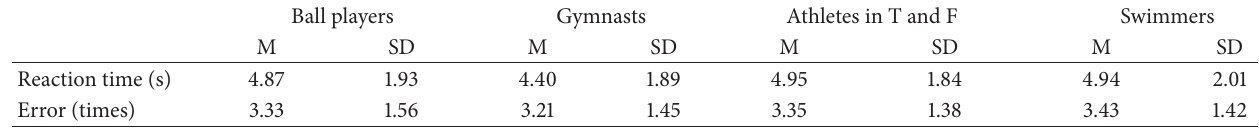
Table 3: Visual image operation performance of subjects of different sports